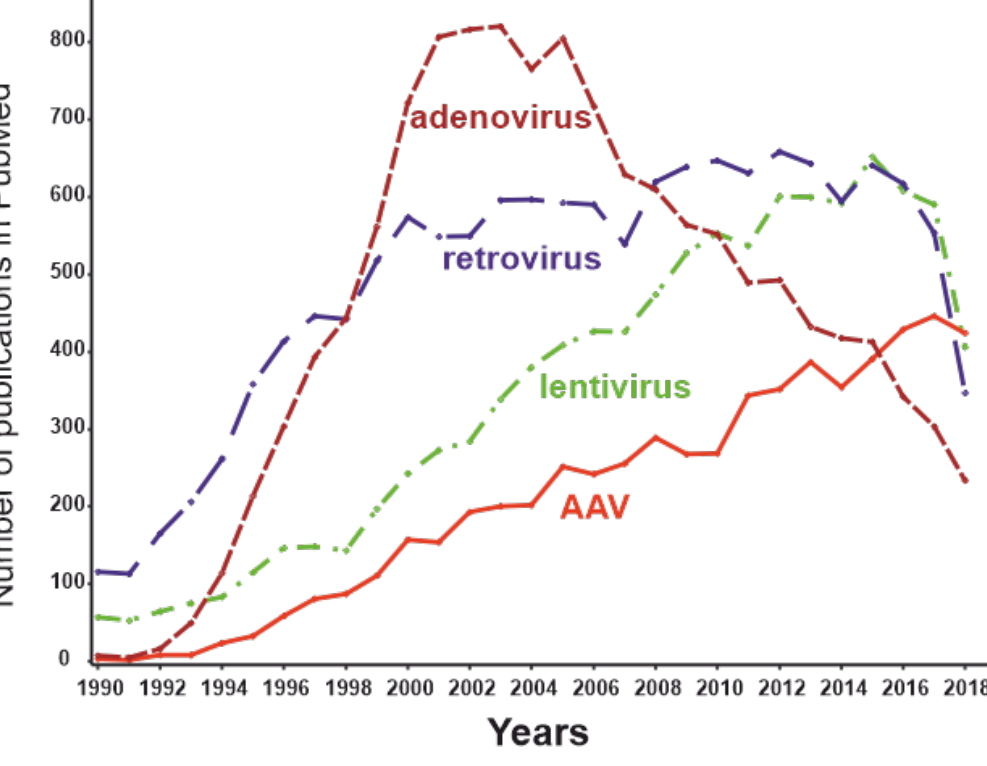
Figure 4. The dynamics of the number of publications with keywords “adeno-associated virus” AND “gene therapy” (red), “lentivirus” AND “gene therapy” (green), “retrovirus” AND “gene therapy” (blue), and “adenovirus” AND “gene therapy” (brown) as of May 2019. Retroviruses are notorious for their capacity to cause AIDS and a range of malignancies.